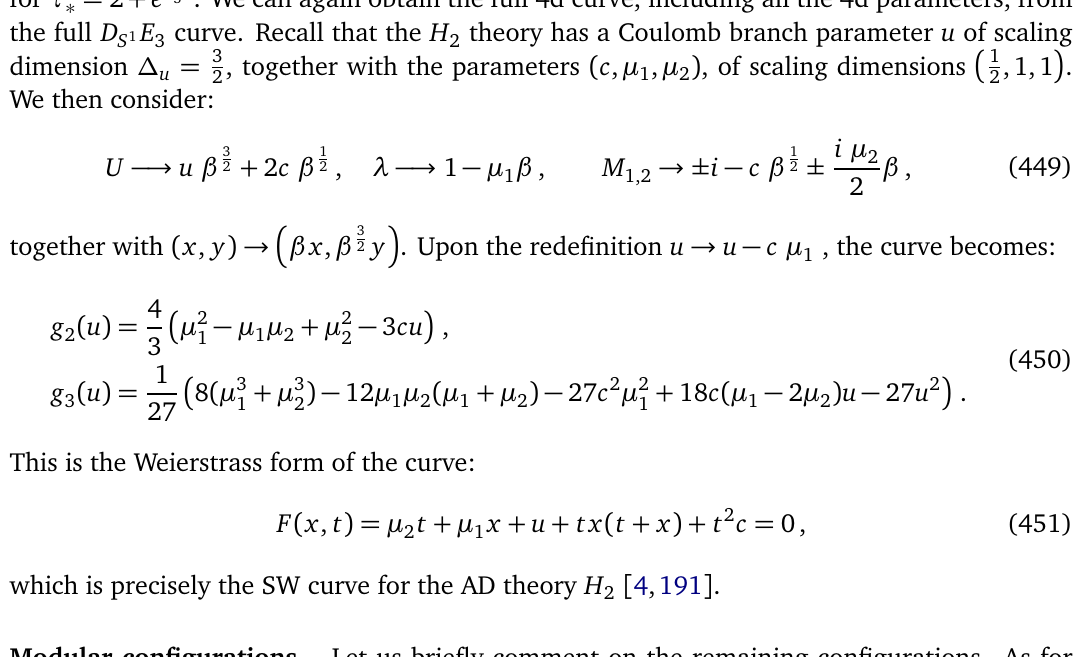
Figure 21: Fundamental domains for two modular configurations on the CB of D